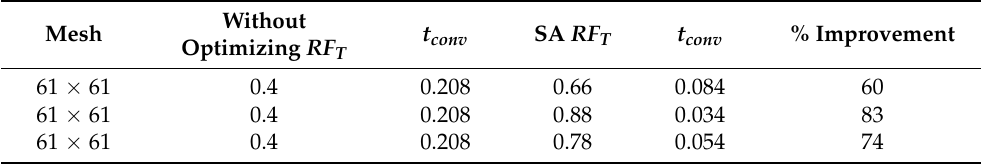
Table 6. Comparison of convergence times obtained from the convection-diffusion problem, applying the RF s obtained with SA vs. RF not optimized with residual value of ε = 1 × 10 − 10 . Without t conv SA RF T t conv % Improvement Mesh Optimizing RF T 61 × 61 0.4 0.208 0.66 0.084 60 61 × 61 0.4 0.208 0.88 0.034 83 61 × 61 0.4 0.208 0.78 0.054